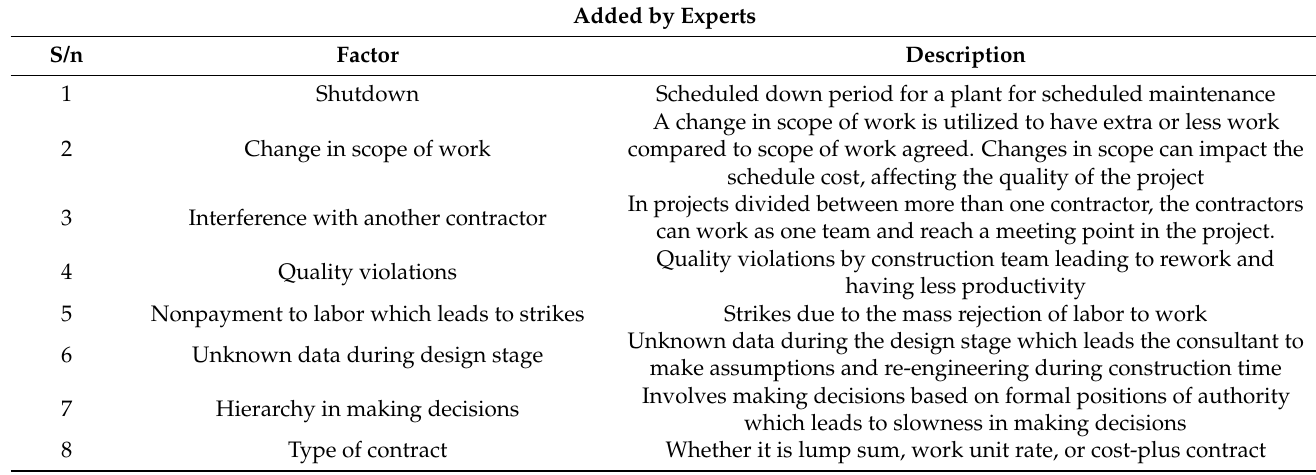
Table 2. Factors Added by